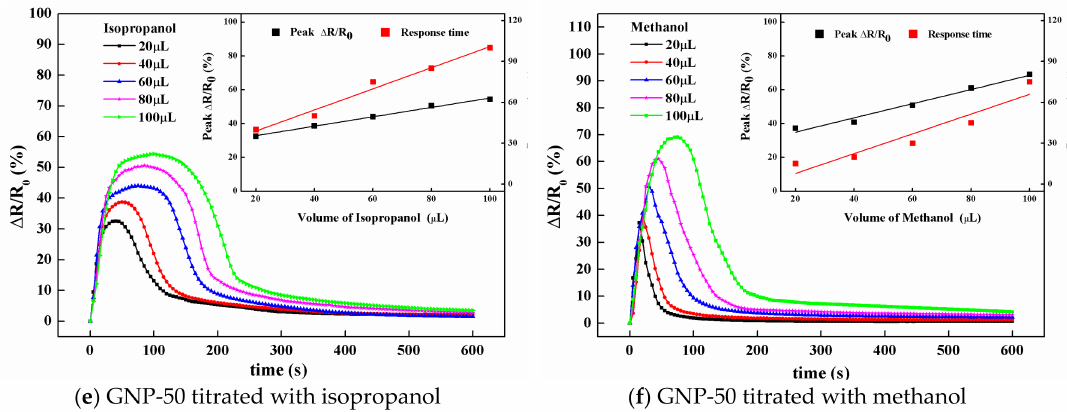
Figure 15. Resistance changes of the hybrid films titrated with different amounts of isopropanol and methanol.